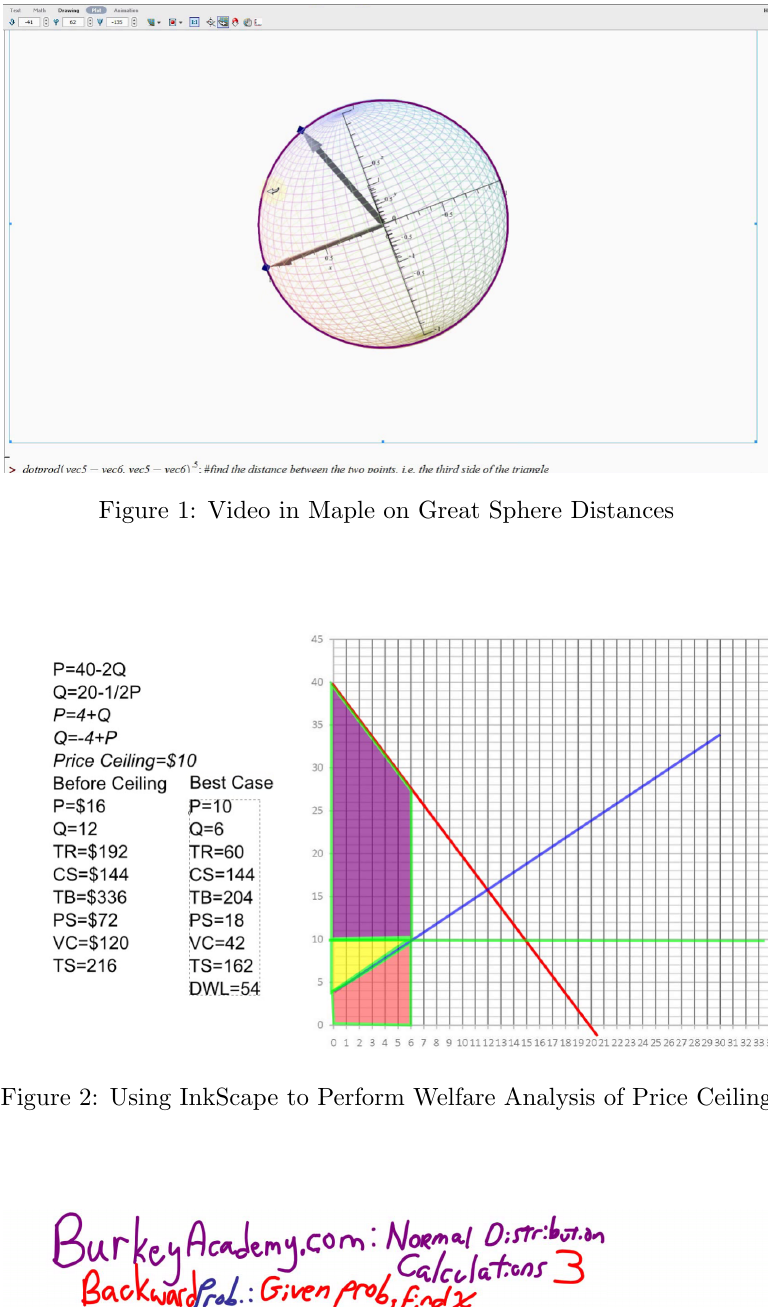
REGION : Volume 2, Number 2,